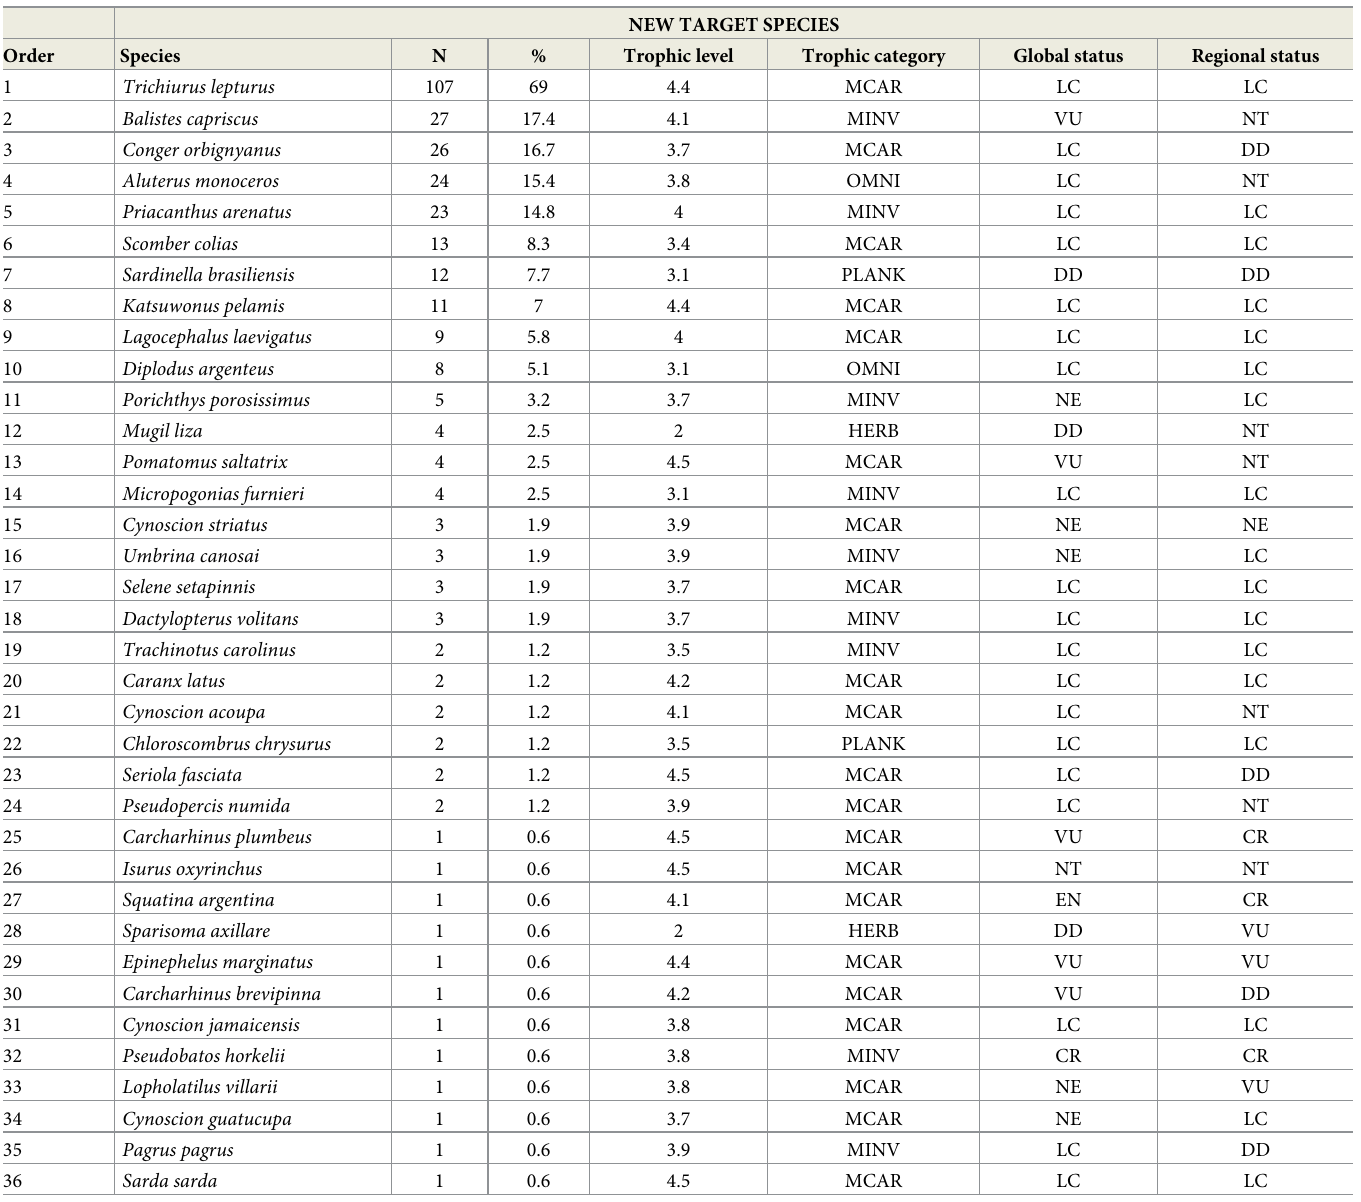
Table 2. Species cited as new targets by fishers, in descending order of reports